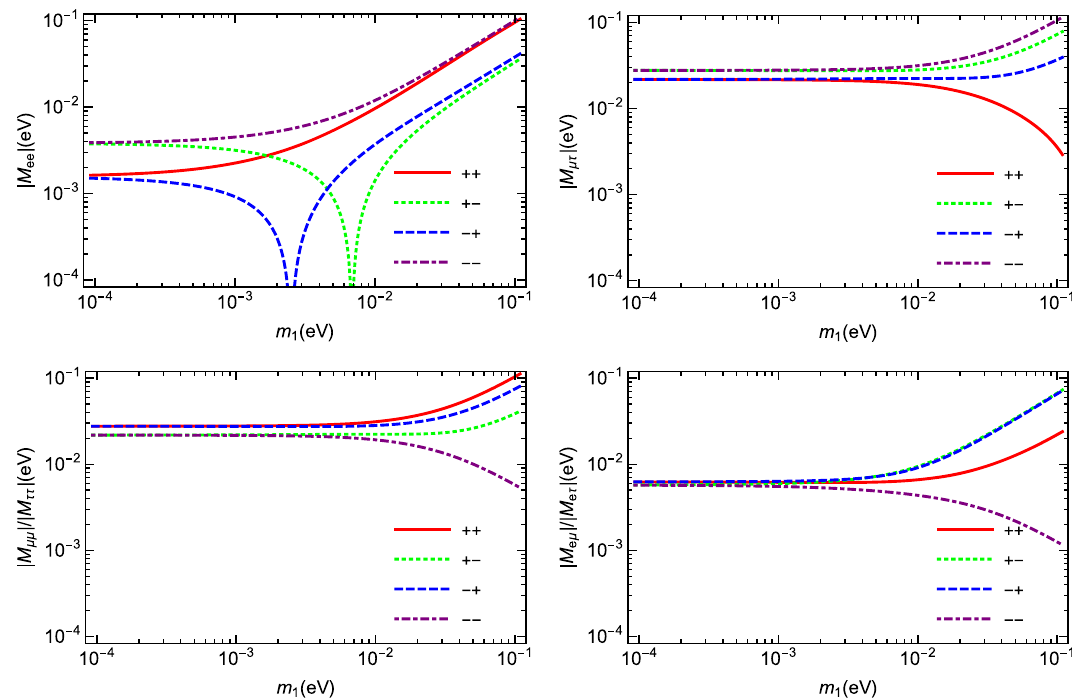
Fig. 3 In the TM1 μ - τ reflection symmetry scenario, | M αβ | as functions of the lightest neutrino mass m ( 1 , 1 ),( 1 , − 1 ),( − 1 , 1 ) and ( − 1 , − 1 ) (denoted as ++ , −+ , +− and −− , respectively)